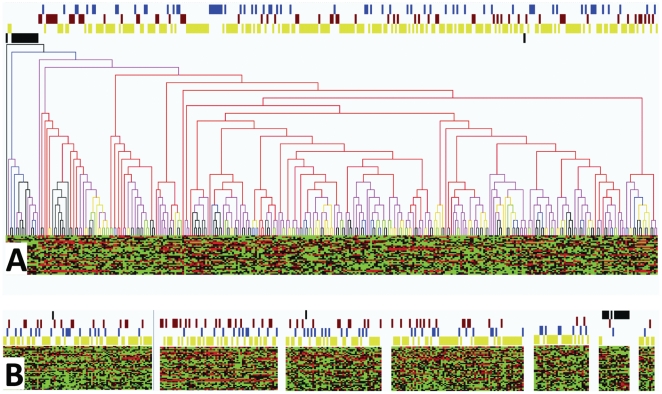
Unsupervised Classification (HCS, KMS) Colored by Survival Phenotype.The topmost color gradient bar displays the scale along which the Log2 (tumor/control) values for each gene are colorized in the dendrogram. The color bars immediately above the dendrogram branches indicate the survival phenotype group to which each sample belongs: Red = top 20th percentile of survival time; Blue = bottom 20th percentile; Yellow = intermediate percentiles, Black = survival not recorded. A: Hierarchical clustering with support (bootstrapping with 20 iterations) demonstrates no separation by survival phenotype. Support values for each node of the dendrogram also reveal significant inconsistency in clustering, suggesting underlying noise (black = 100% support, gray = 90–99%, blue = 80–89%, green = 70–79%, yellow = 50–69%, pink/red <50%). Only the topmost portion of the full heatmap is depicted in this figure. B: Clusters resulting from k-means support (k = 2, 10 iterations), again showing no segregation by survival phenotype.